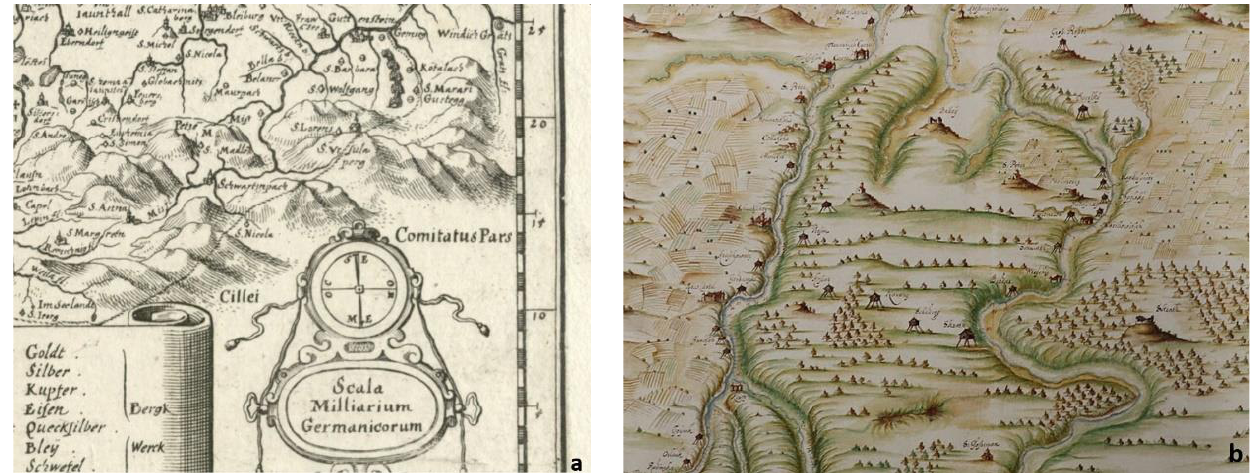
Figure 2. ( a ) A Carinthia map in the second half of the 16th century (I. Holzwurm (1575 – 1617)) [36]; ( b ): watchtowers on the Kolpa river, Slovenia/Croatia state border [37].